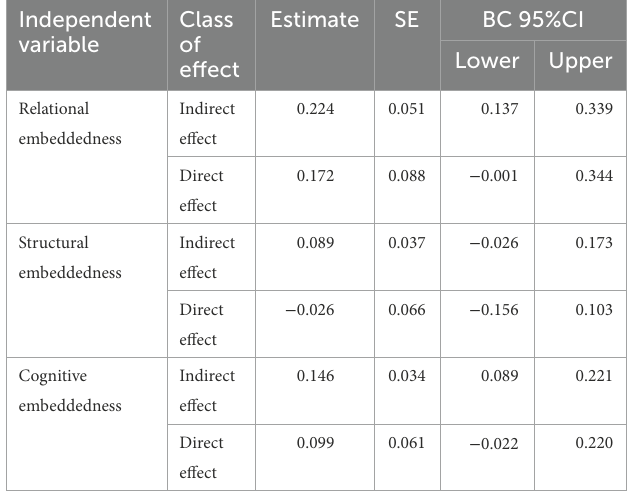
TABLE 5 Robustness test of mediating